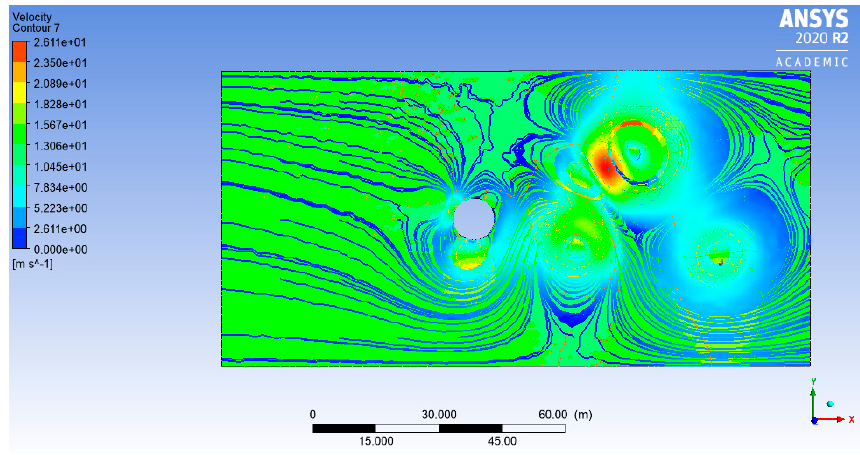
Figure 14. Velocity contour for the flow on the free-floating buoy under 0.45 m/s case.